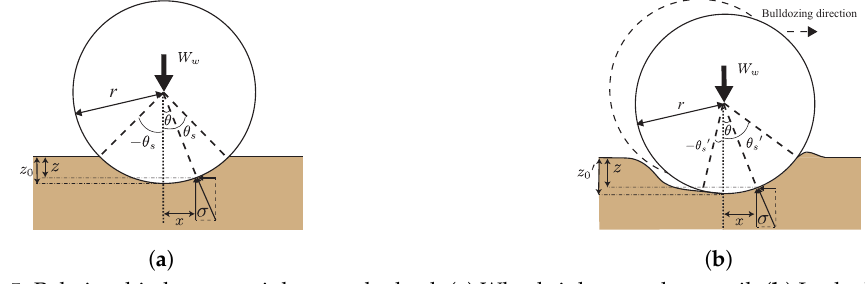
Figure 5. Relationship between sinkage and wheel. ( a ) Wheel sinkage on loose soil. ( b ) Locked-wheel sinkage during